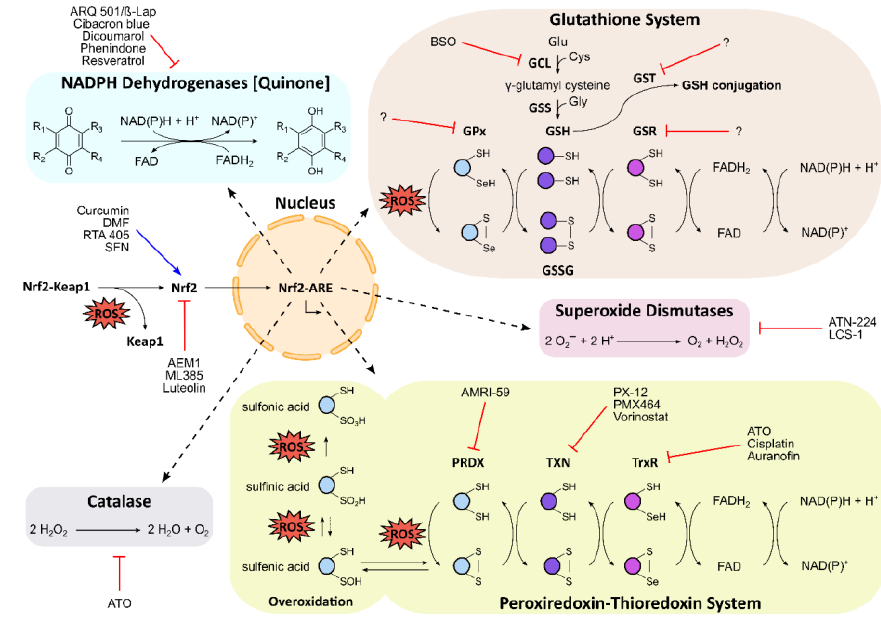
Figure 2. Schematic overview of the antioxidative landscape in the cell, and the corresponding modulators of key players. Reactive oxygen species (ROS) activate the Nrf2–Keap1 signalling pathway, resulting in induction of the antioxidant response elements (ARE) by Nrf2 in the nucleus. ARE comprise the glutathione (GSH) system, the peroxiredoxin–thioredoxin system, and antioxidative enzymes, such as NAD(P)H dehydrogenases [quinone], superoxide dismutases, and catalase. In the GSH system, the sequential activity of glutamate cysteine ligase (GCL) and glutathione synthetase (GSS) produces the tripeptide GSH. Glutathione peroxidases (GPx), which are often selenoproteins, use GSH to scavenge ROS, resulting in glutathione disulfide (GSSG). Glutathione reductase (GSR) regenerates GSH using FAD and NAD(P)H. GSH is also used for conjugation by glutathione S-transferase (GST) in cellular detoxification processes. In the peroxiredoxin–thioredoxin system, ROS are scavenged by peroxiredoxin (PRDX), resulting in oxidation of PRDX’s peroxidatic cysteine to sulfenic acid or disulfide bonds. Overoxidation yields sulfinic or irreversible sulfonic acid. Thioredoxin (TXN) and the selenoprotein thioredoxin reductase (TxR) regenerate PRDX using FAD and NAD(P)H. Names of pharmaceutical and experimental inhibitors and activators are presented, and the corresponding target sites are indicated by red lines or blue arrows, respectively.